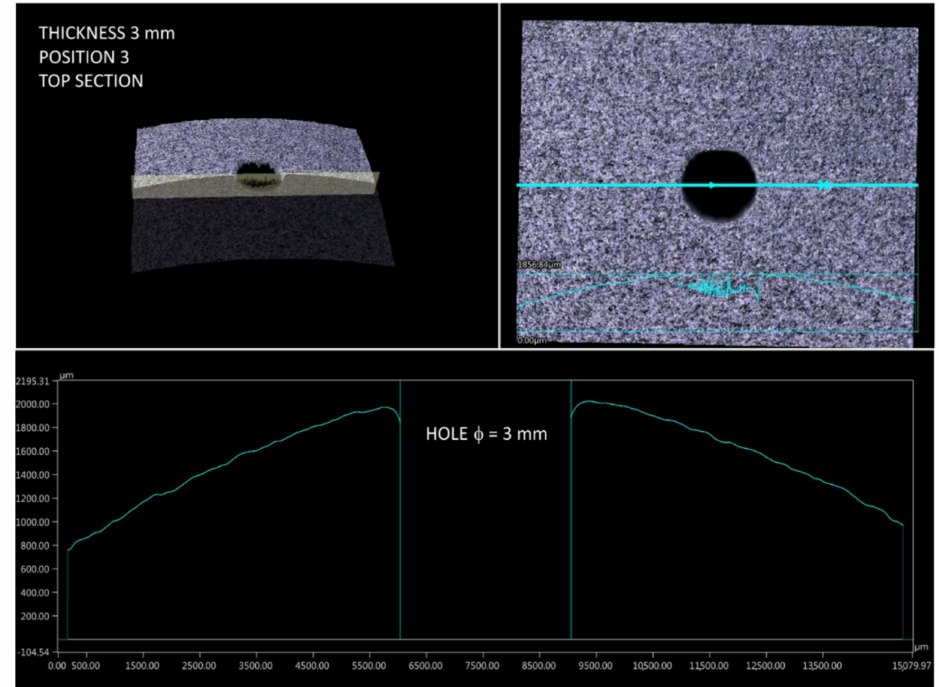
Figure 17. Surface profile of part 3.3 (top section).